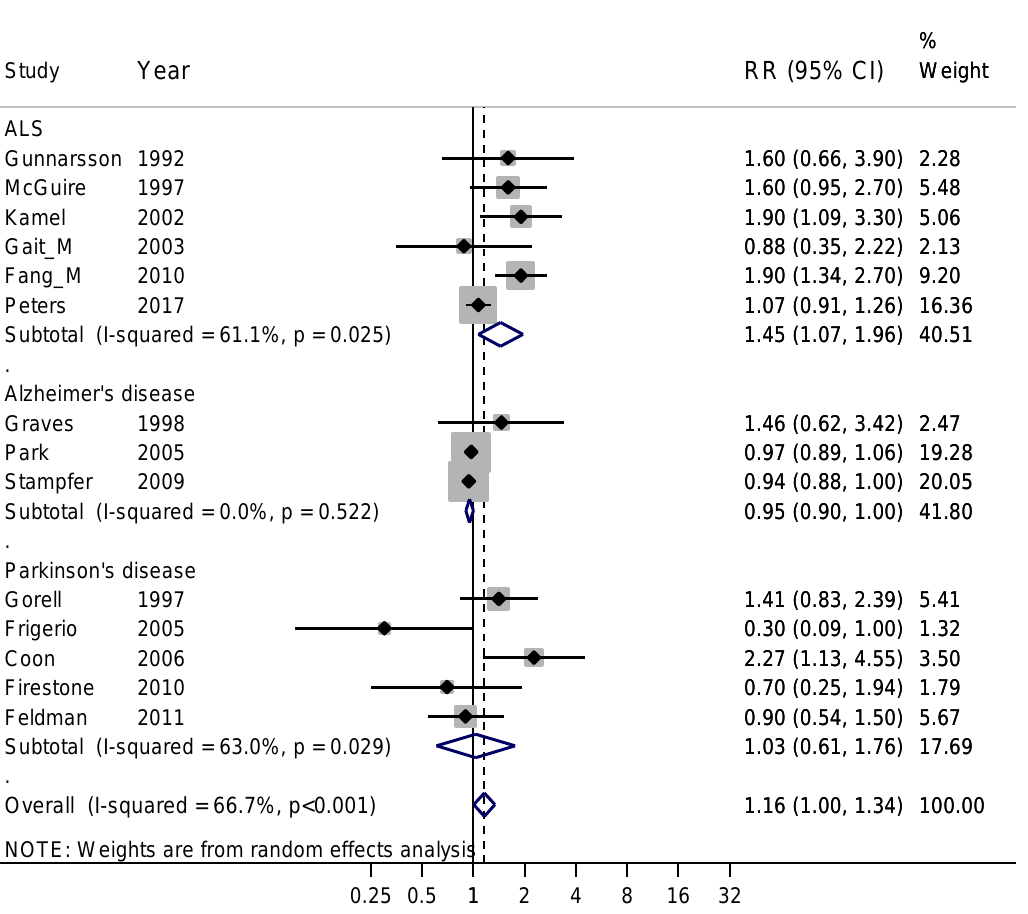
Figure 7. Forest plot for studies assessing the association between amyotrophic lateral sclerosis (ALS), Alzheimer’s disease and Parkinson’s disease and occupational exposure to metals. Results for men only are indicated by M, otherwise the results concern both sexes. Random effect models were used, with stratification by diagnosis. Heterogeneity was tested by the I 2 statistic ( I -squared), with p < 0.05 indicating rejection of homogeneity. CI = confidence interval; RR = relative risk.